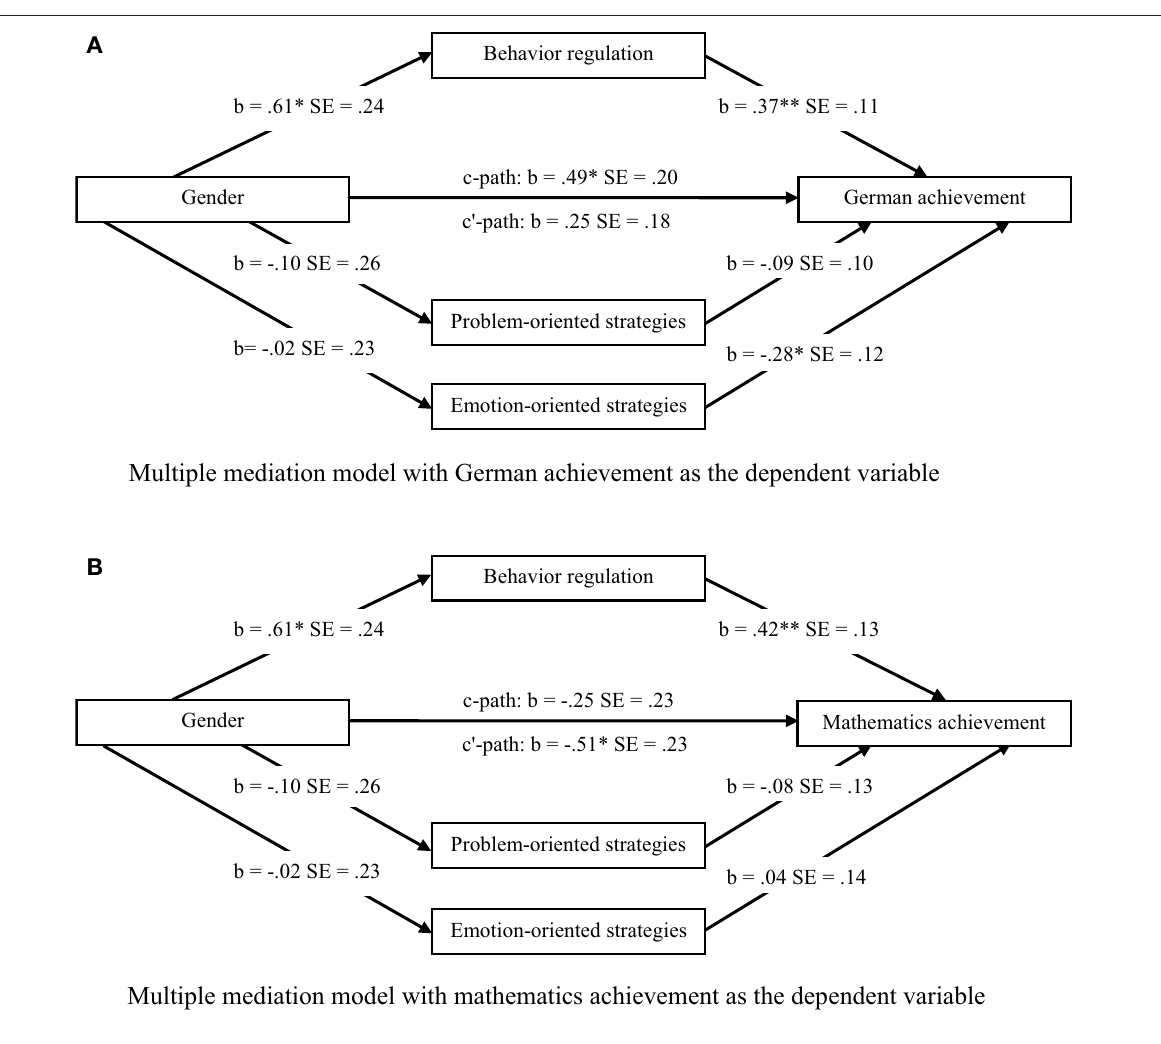
strategies (A) . Multiple mediation test of the relation between gender and mathematics achievement mediated by behavior regulation, problem-oriented strategies, and emotion-oriented strategies (B) . N = 53; b = unstandardized regression coefficient, controlled for age and intelligence; ∗ p < . 05; ∗∗ p < .